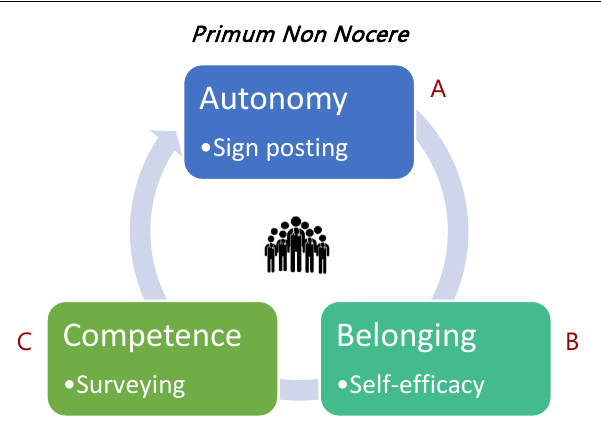
Figure 1 . A Call to Review Healthcare Worker’s Wellbeing. Schematic Proposing Approached to Supplement the GMC’s ABC Approach and Uphold the Wellbeing of Healthcare